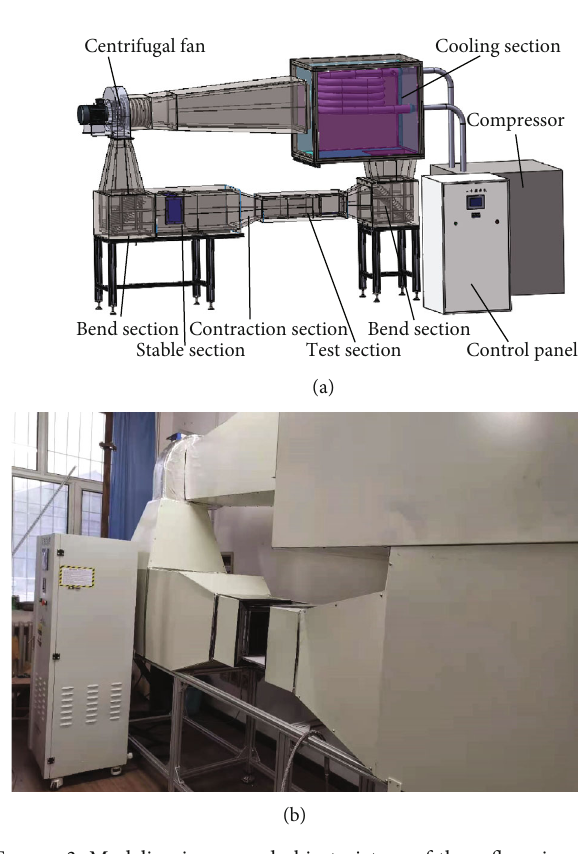
Figure 3: Modeling image and object picture of the re fl ux airway: (a) modeling image and (b) object